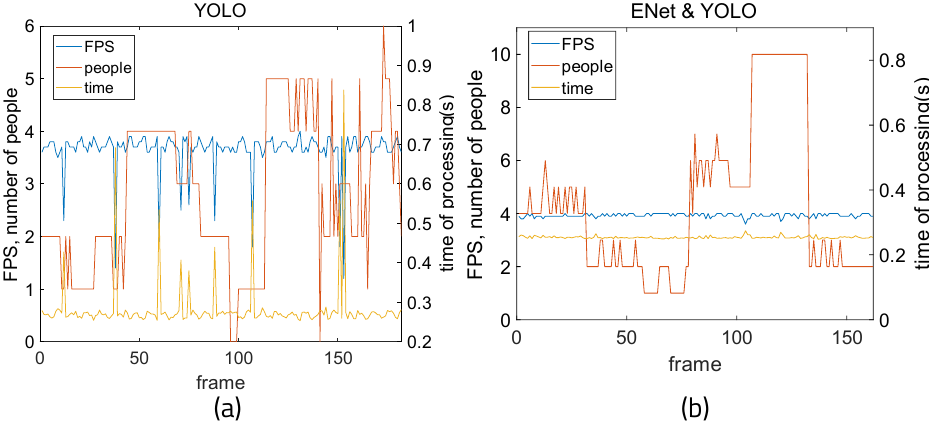
Figure 13. Time measurement: ( a ) YOLO and ( b ) YOLO executed with ENet.